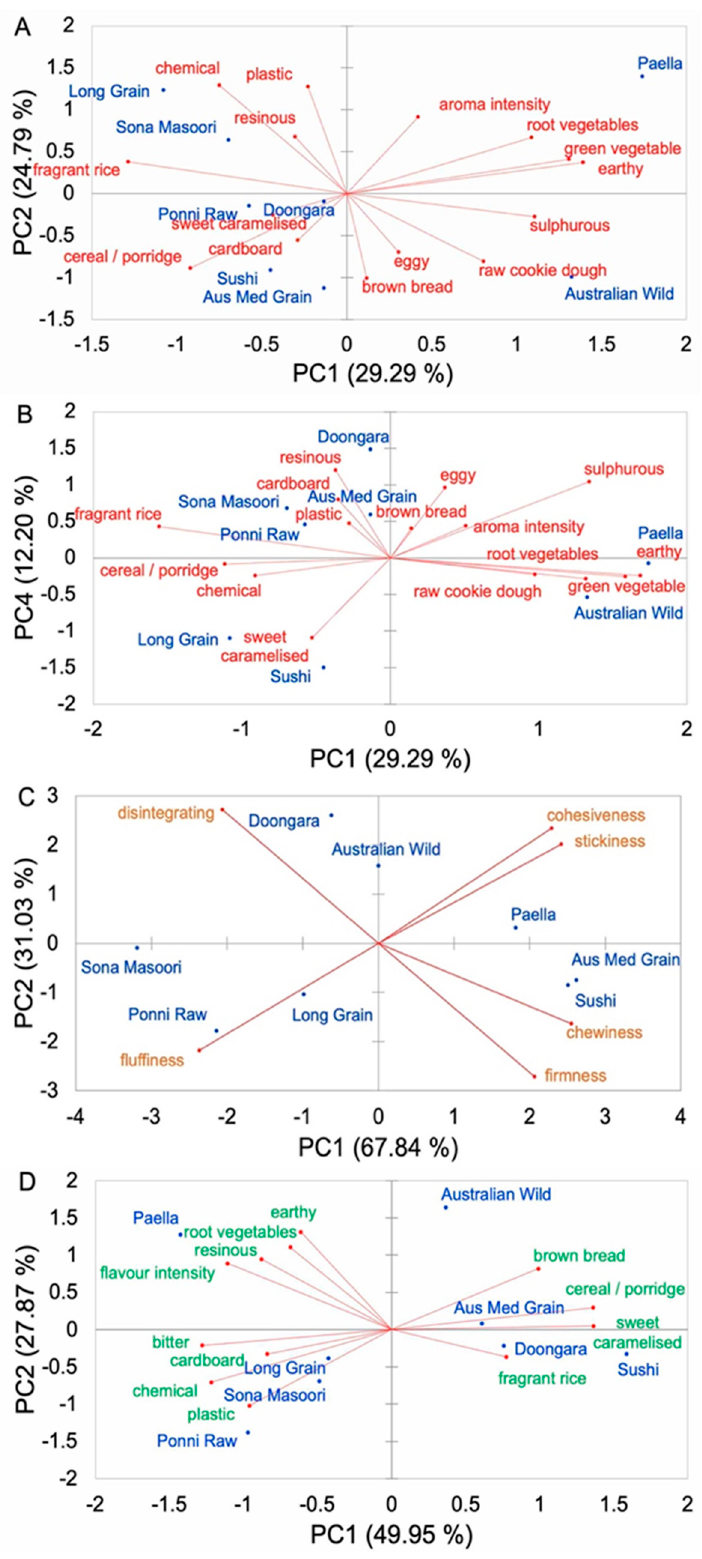
Figure 1. PCA bi-plot of the sensory properties of 8 cooked polished rice samples ( n = 3 replicates × 11 panelists). ( A , B ) aroma attributes; ( C ) texture attributes; ( D ) flavor attributes.